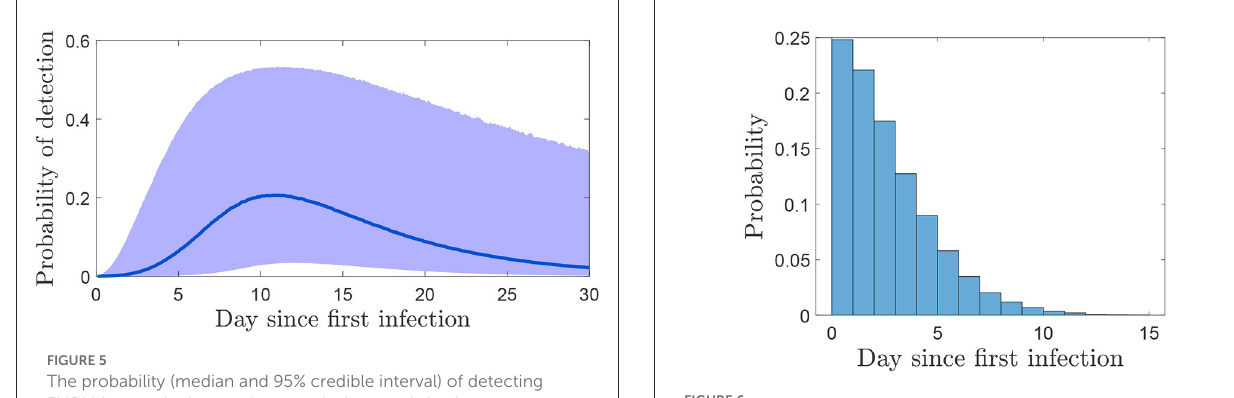
The probability of different time intervals between an infected herd infecting another premises and it being detected. This can be seen as the day that the other premises would be considered at risk and sampling would start. We exclude negative values as they indicate that infection occurs after detection. Estimates for herd generation time are made from viral shedding ( T gd ) in (16) and detection